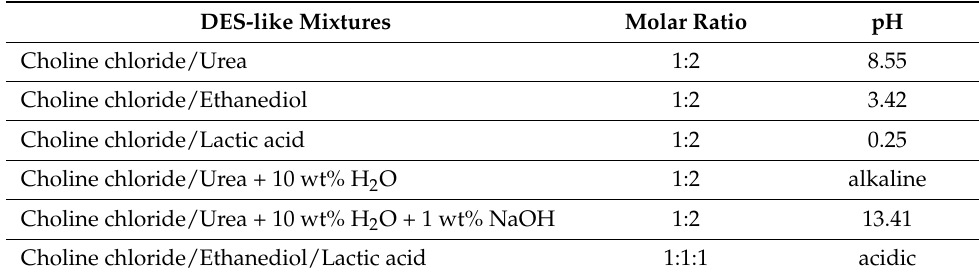
Table 1. Composition of DES-like mixtures and their pH values (adapted according to Teng et al.) [22]. DES-like Mixtures Molar